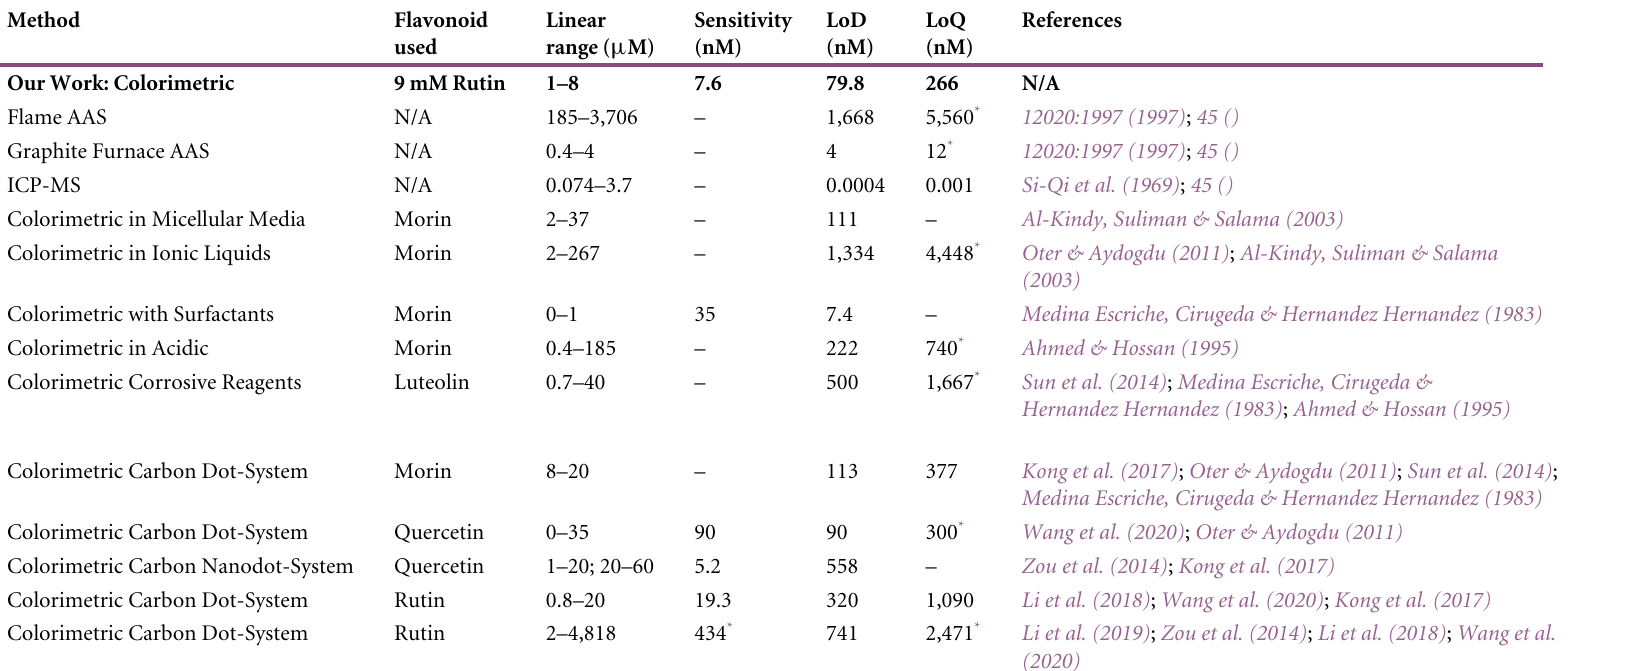
Table 3 Comparative performance of advanced instrumentation and flavonoid-based colorimetric methods for Al 3 +